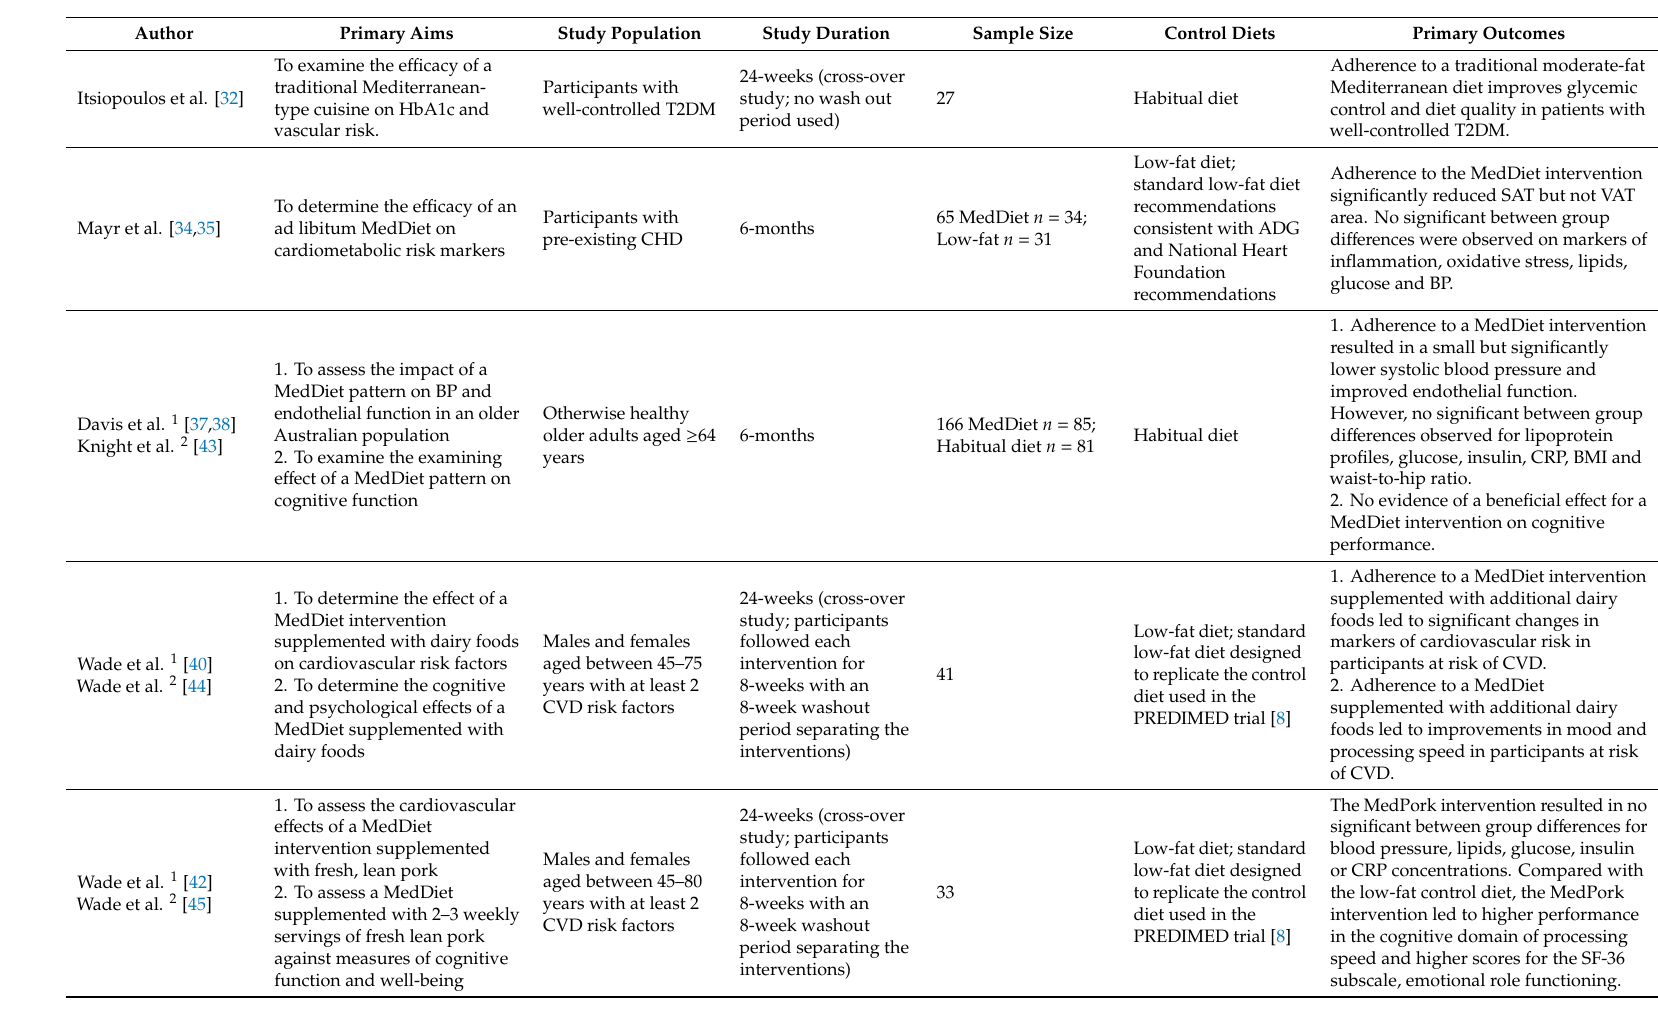
Table 1. Characteristics of included studies related to the e ffi cacy of a Mediterranean Diet in randomized control trials conducted in